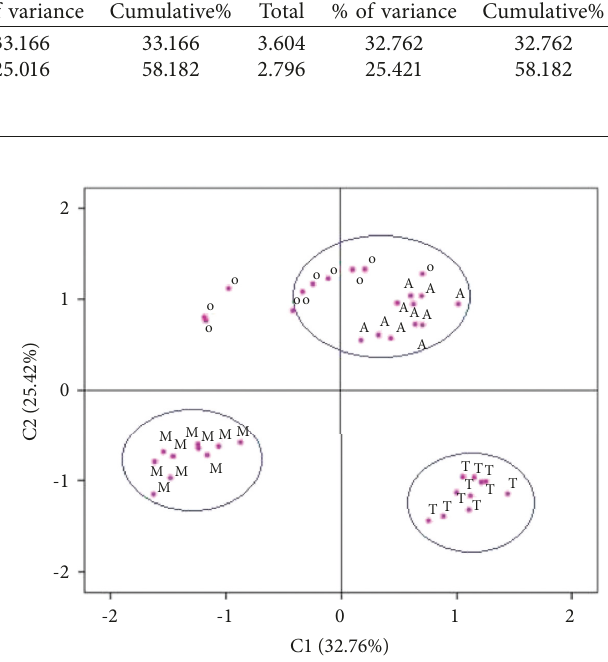
Figure 2: Dispersion diagram of the first two principal coordinates ( C 1 and C 2 ) of the PCA for the traits studied in the four populations of Cedrus atlantica . A , A¨ıt Ayach; T , Tazekka; O , A¨ıt Oufella; M , Moudemame.